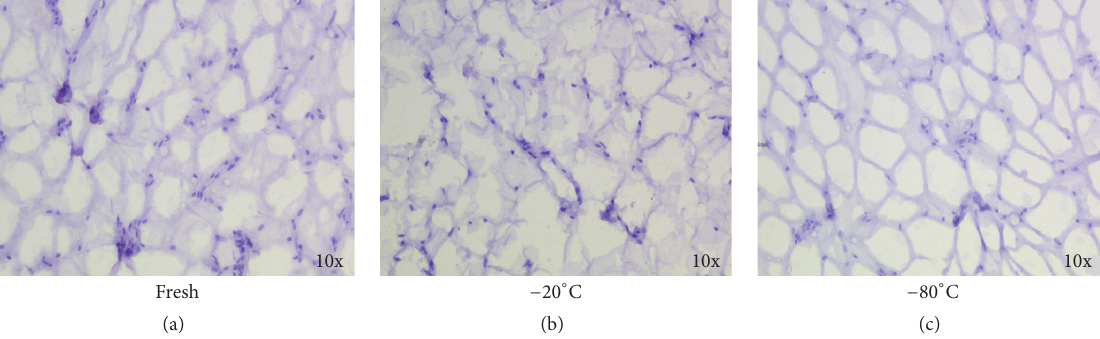
Figure 4: Adipose tissue is better preserved at − 80 ∘ C than − 20 ∘ C. The samples cryopreserved at − 20 ∘ C (b) showed a damaged structure compared to fresh (a) and − 80 ∘ C